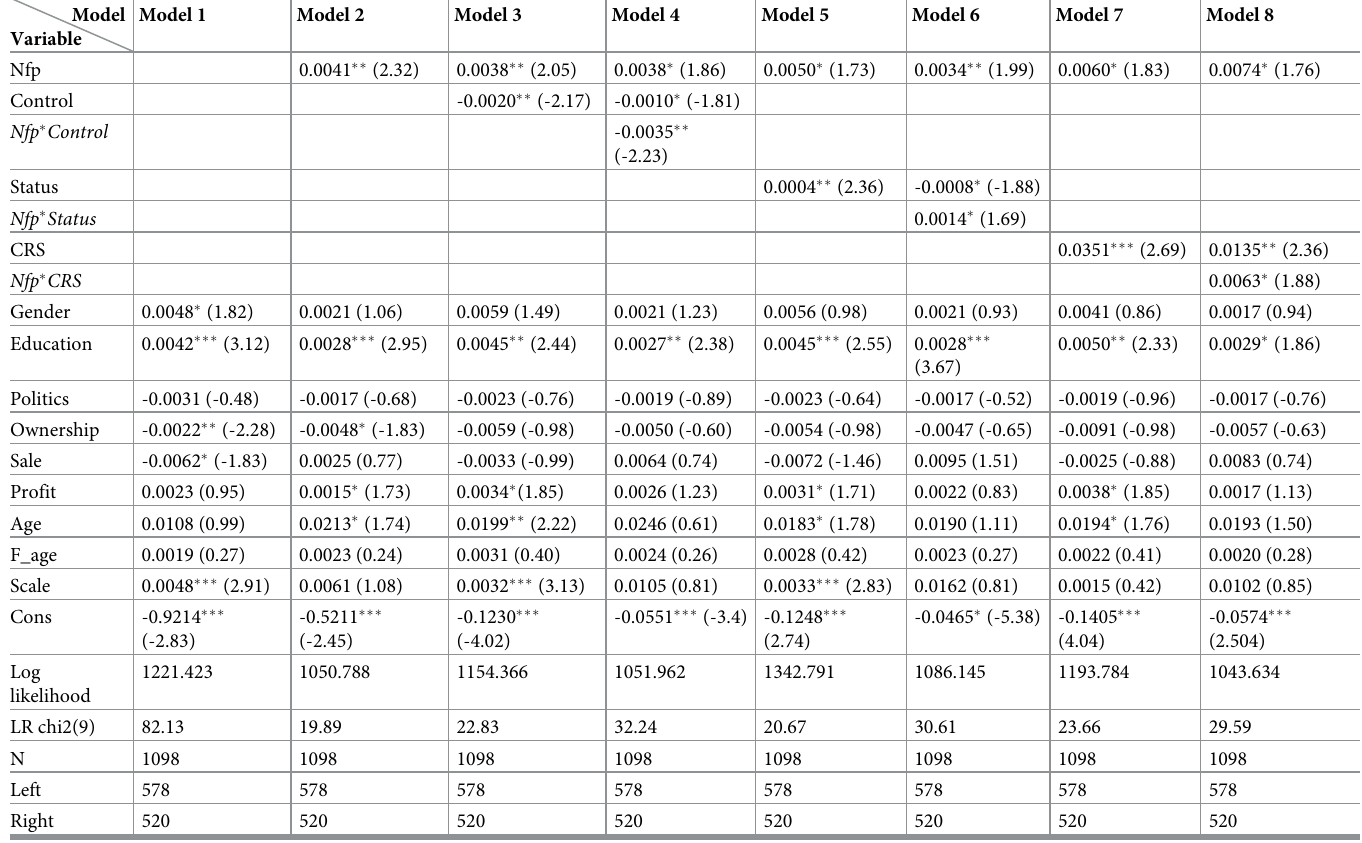
Table 2. Results of Tobit regression analyses for R&D intensity of